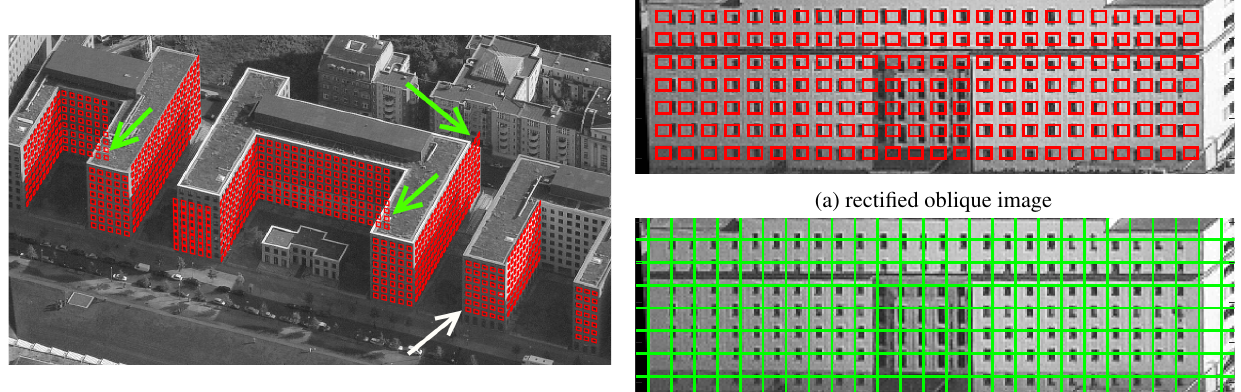
Figure 7. Building complex ’Berliner Park Kolonnaden’.